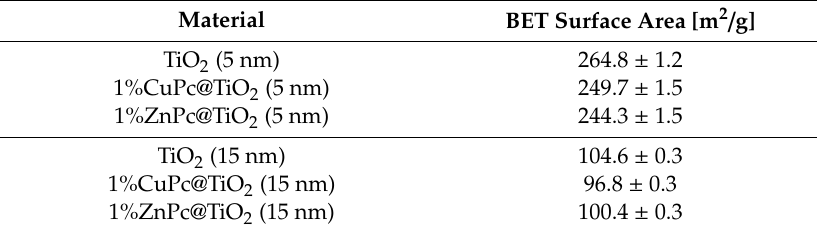
Table 3. Brunauer–Emmett–Teller (BET) surface area measured for the materials